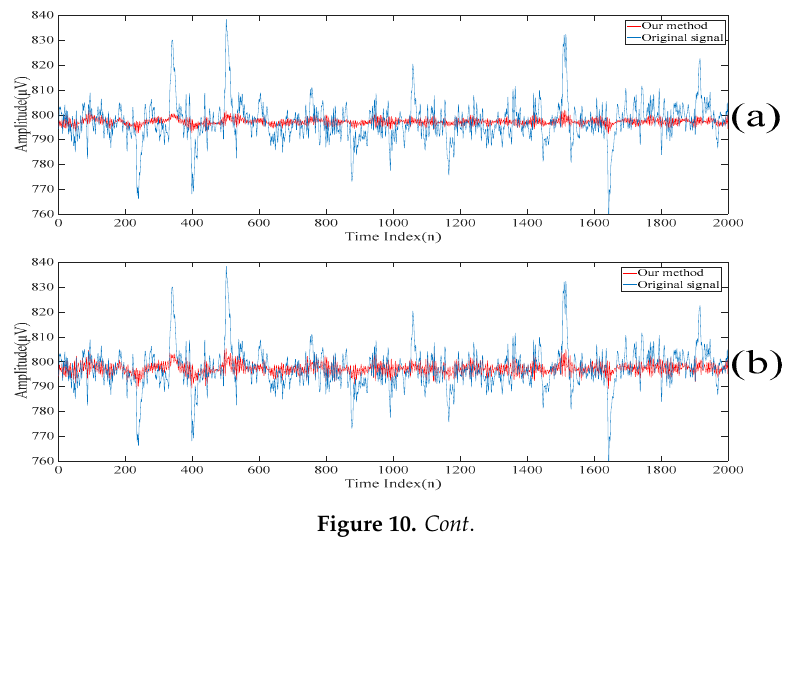
Figure 9. The second scale of the electroencephalogram.